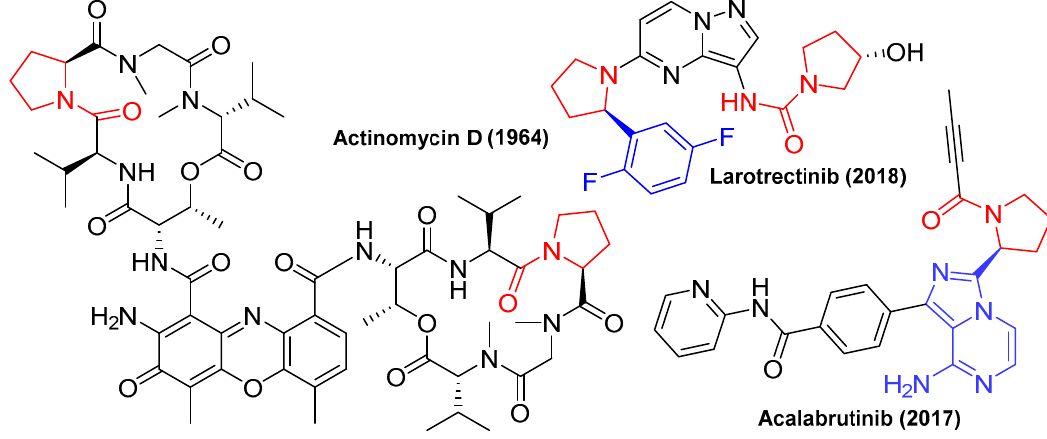
Figure 1. Approved anti-cancer drugs possessing 2-substituted N -carboxypyrrolidine